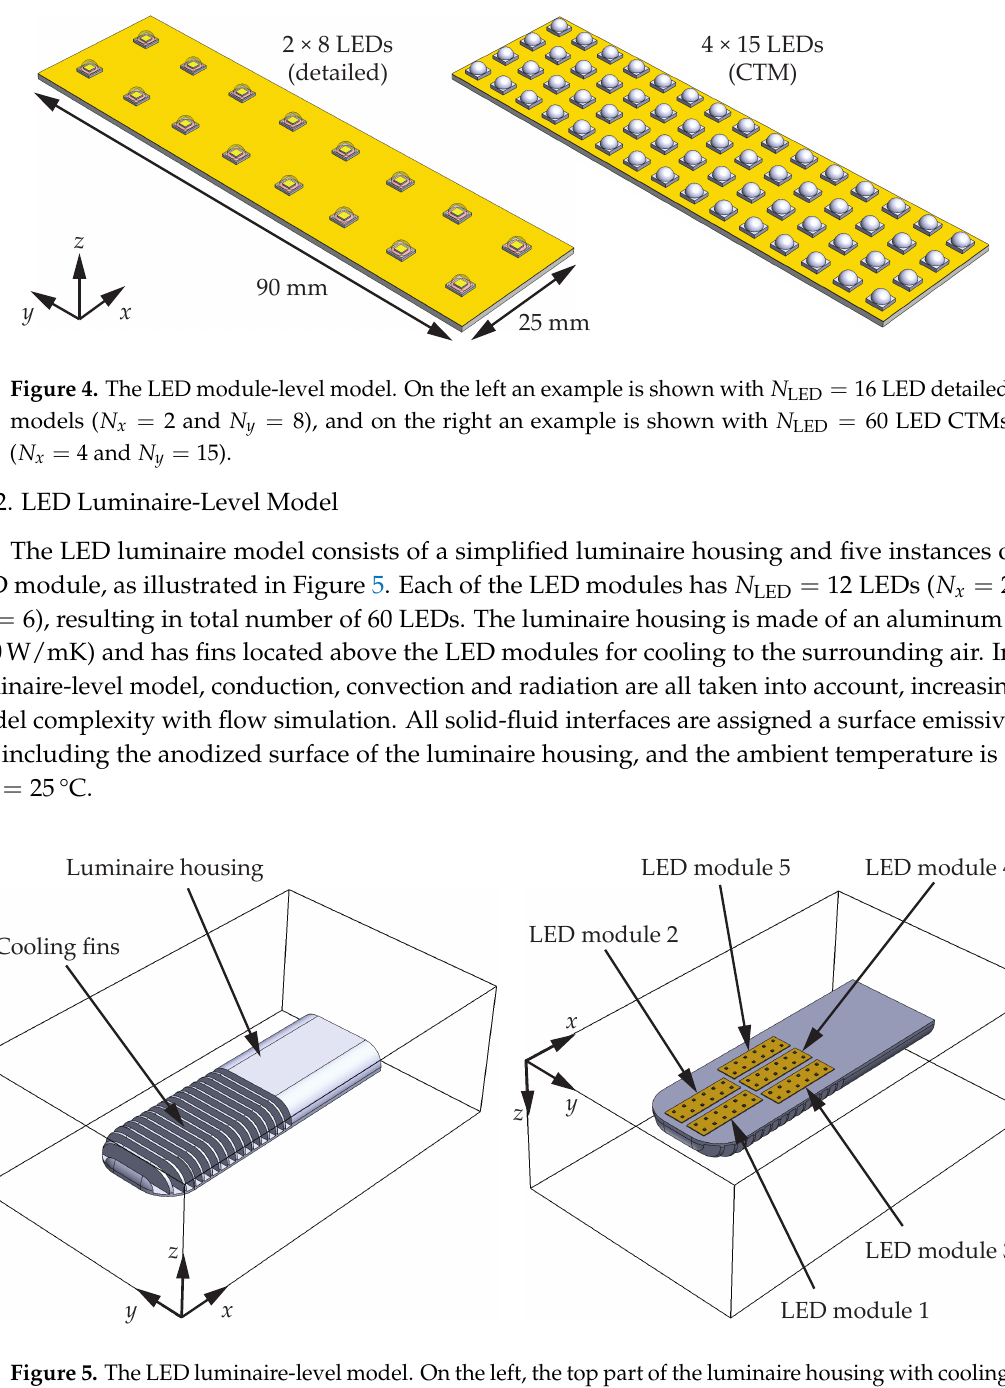
Figure 5. The LED luminaire-level model. On the left, the top part of the luminaire housing with cooling fins is visible, and on the right, the bottom part of the luminaire housing is visible, which supports five LED modules each with 12 LEDs ( N x = 2 and N y = 6). The rectangular outlines indicate the computational